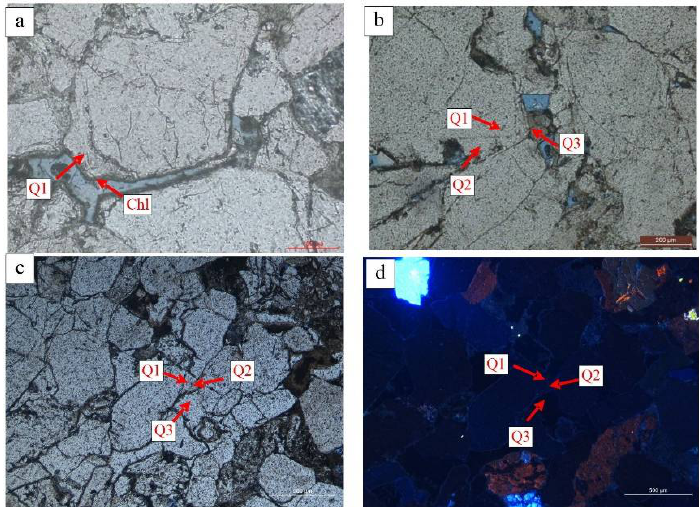
Figure 4. Photomicrographs showing the characteristics of the quartz cements. ( a ) Q1 quartz cement, which precipitated earlier than the chlorite-coated did, JH2 well, 3419 m, PPL; ( b ) Three phases of the quartz cements referred to as Q1, Q2, and Q3, X10 well, 4880.54 m, PPL; ( c ) Three phases of the quartz cements referred to as Q1, Q2, and Q3, JH2 well, 3440.42 m, PPL; ( d ) Three phases of the quartz cements referred to as Q1, Q2, and Q3, JH2 well, 3440.42 m, CL.